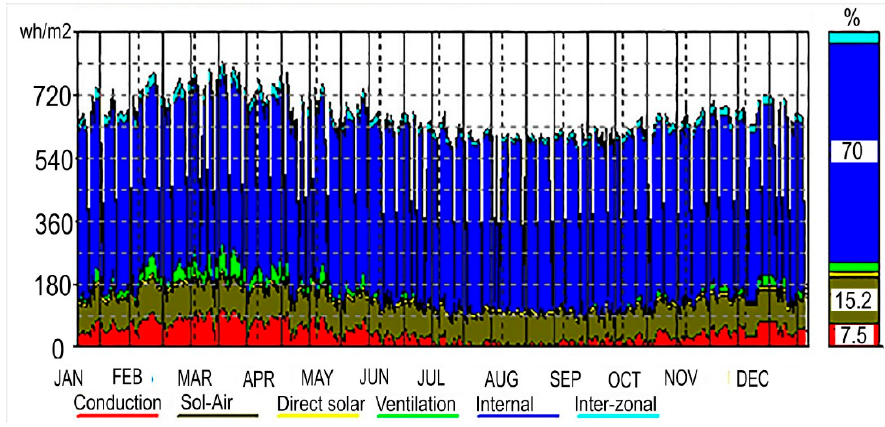
Figure 13. Heat gains breakdown.